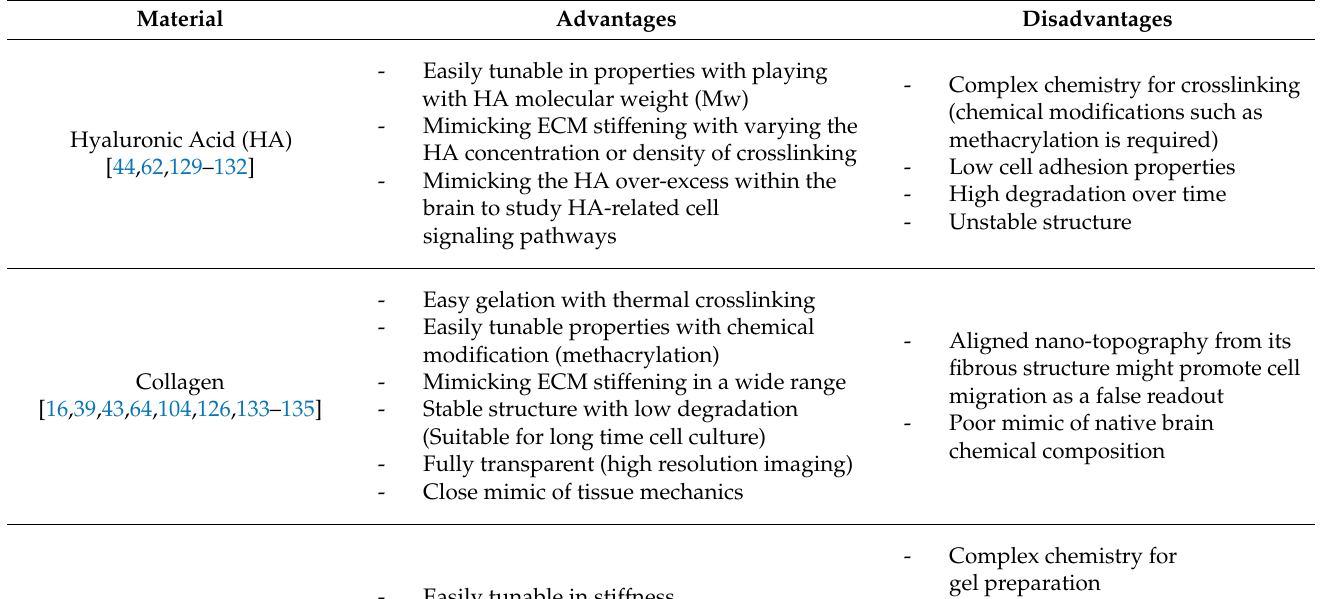
Table 1. The five widely used materials as hydrogels to mimic the glioblastoma tumor microenviron- ment for cell studies. Advantages and limitations of each material are